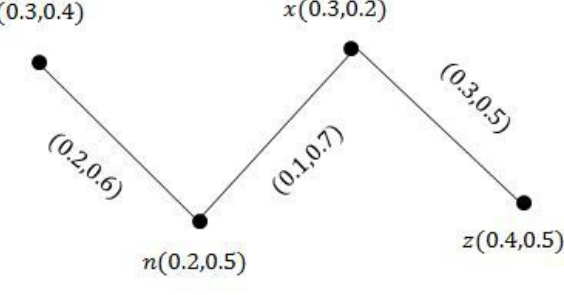
Figure 9. Neighborly Edge Irregular Vague Graph (NEIVG) ( G ).